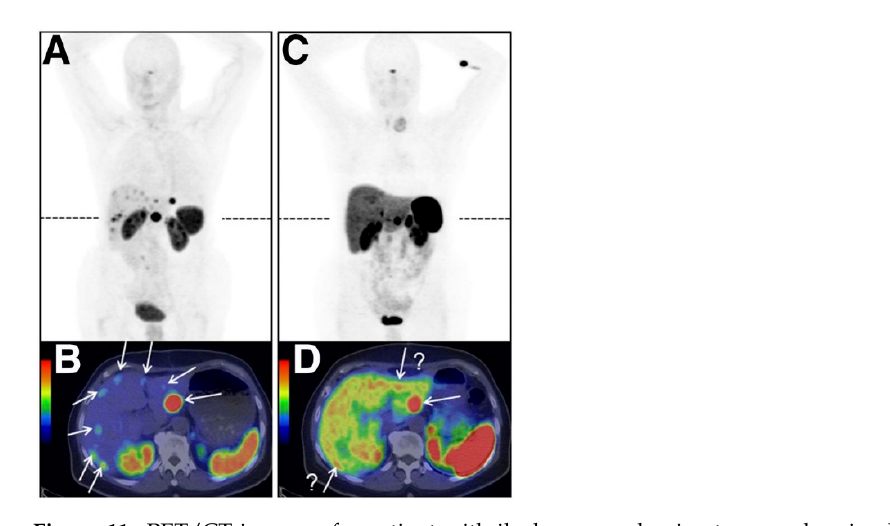
Figure 11. PET/CT images of a patient with ileal neuroendocrine tumors showing bilobar liver metastases (marked with arrows) after application of [ 68 Ga]Ga-OPS202 ( A ) and its transaxial fusion image ( B ) and [ 68 Ga]Ga-DOTATOC ( C ) and its transaxial fusion image ( D ) (adapted from [60]).